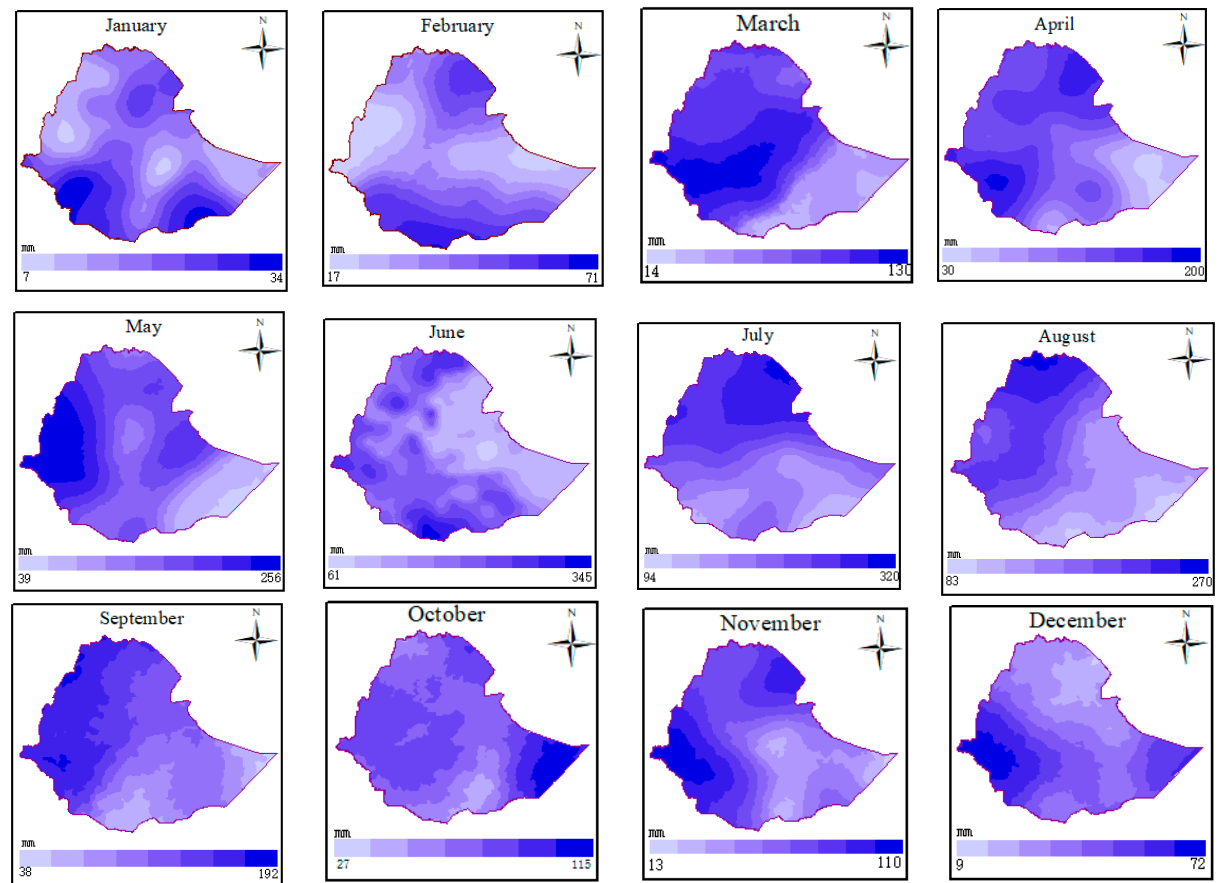
Figure 5. High-resolution maps of the mean monthly precipitation in Ethiopia during 1990–2020 generated using the hybrid of MLPs.